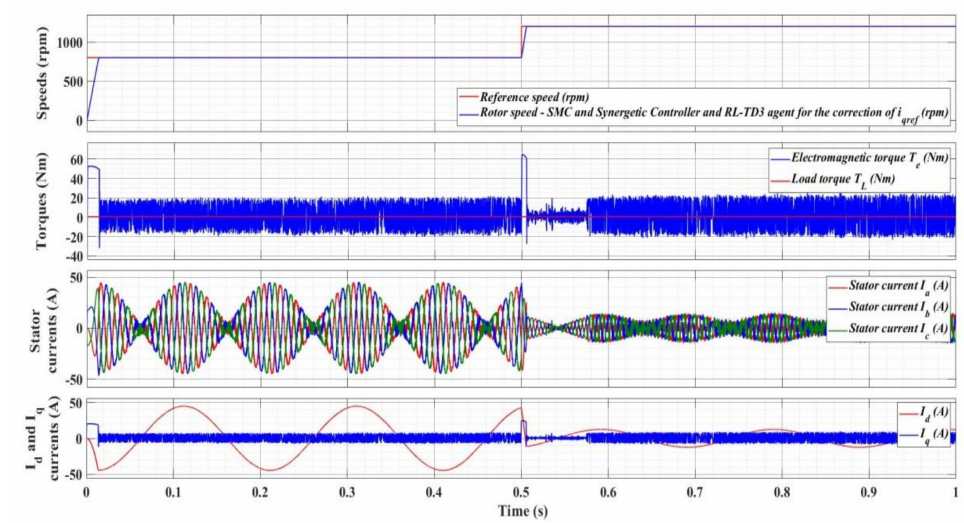
Figure 33. Time evolution for the numerical simulation of the PMSM control system based on control using SMC and synergetic controllers using an RL-TD3 agent for the correction of i qref .